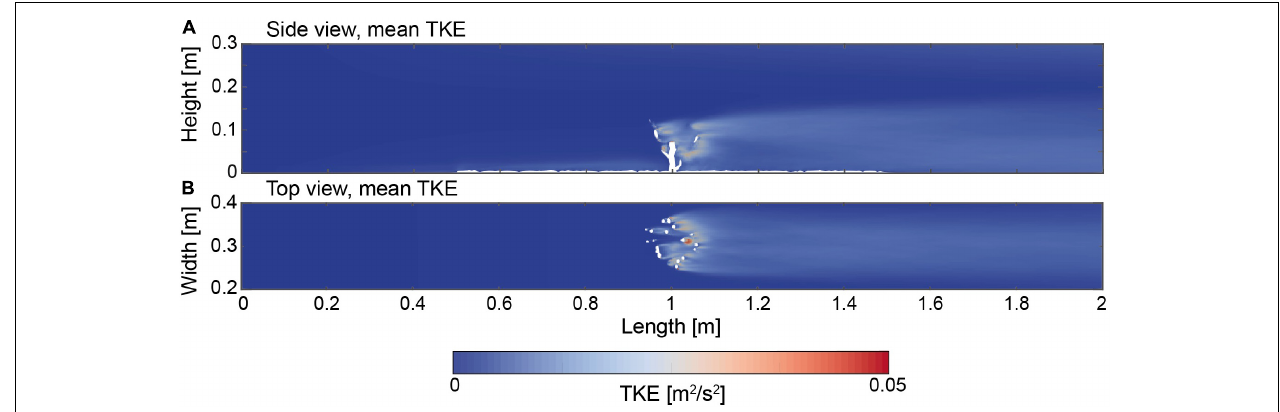
FIGURE 8 | (A) Side view ( Y = 0.15 m) indicating the turbulent kinetic energy (TKE) field as a time average. (B) Top view ( Z = 0.05 m) indicating the turbulent kinetic energy field as a time average.